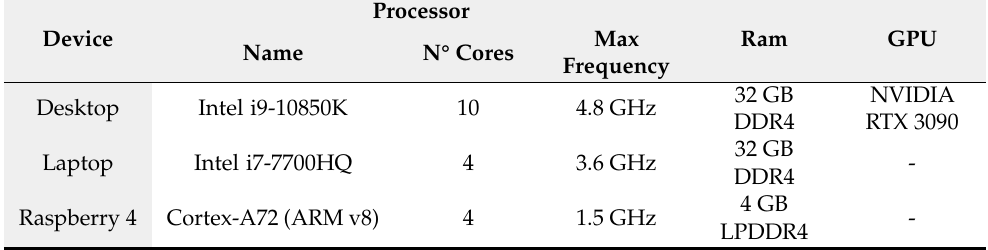
Table 4. Hardware specification of the devices used to compute the SFPT across all experiments. Processor